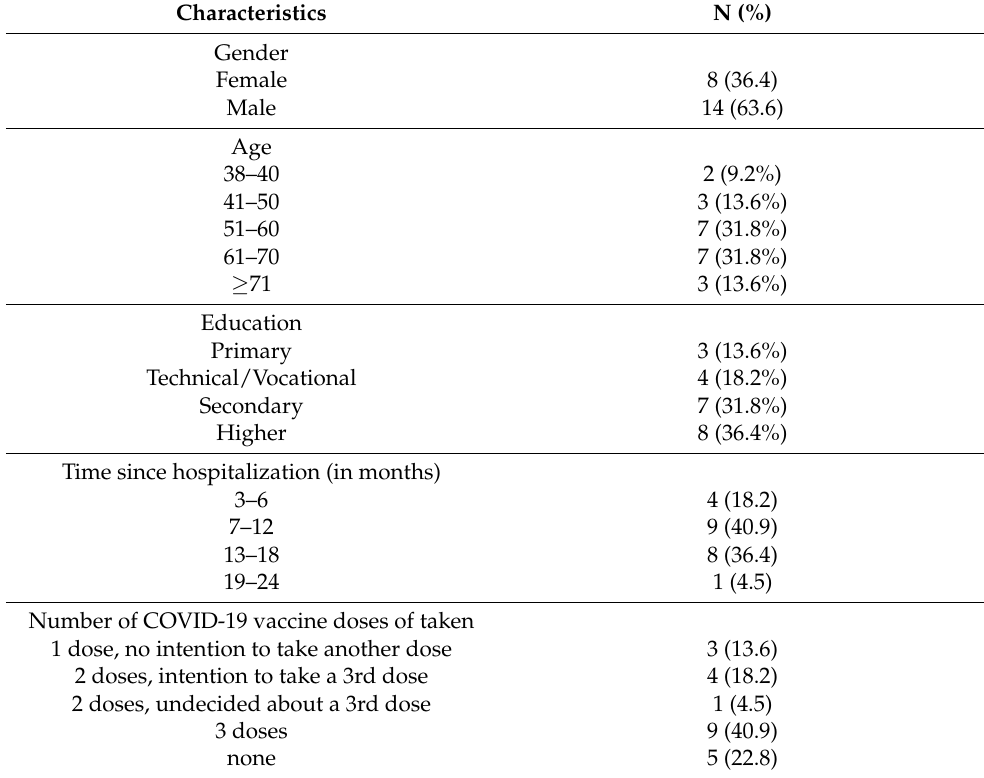
Table 1. Participant characteristics (N =